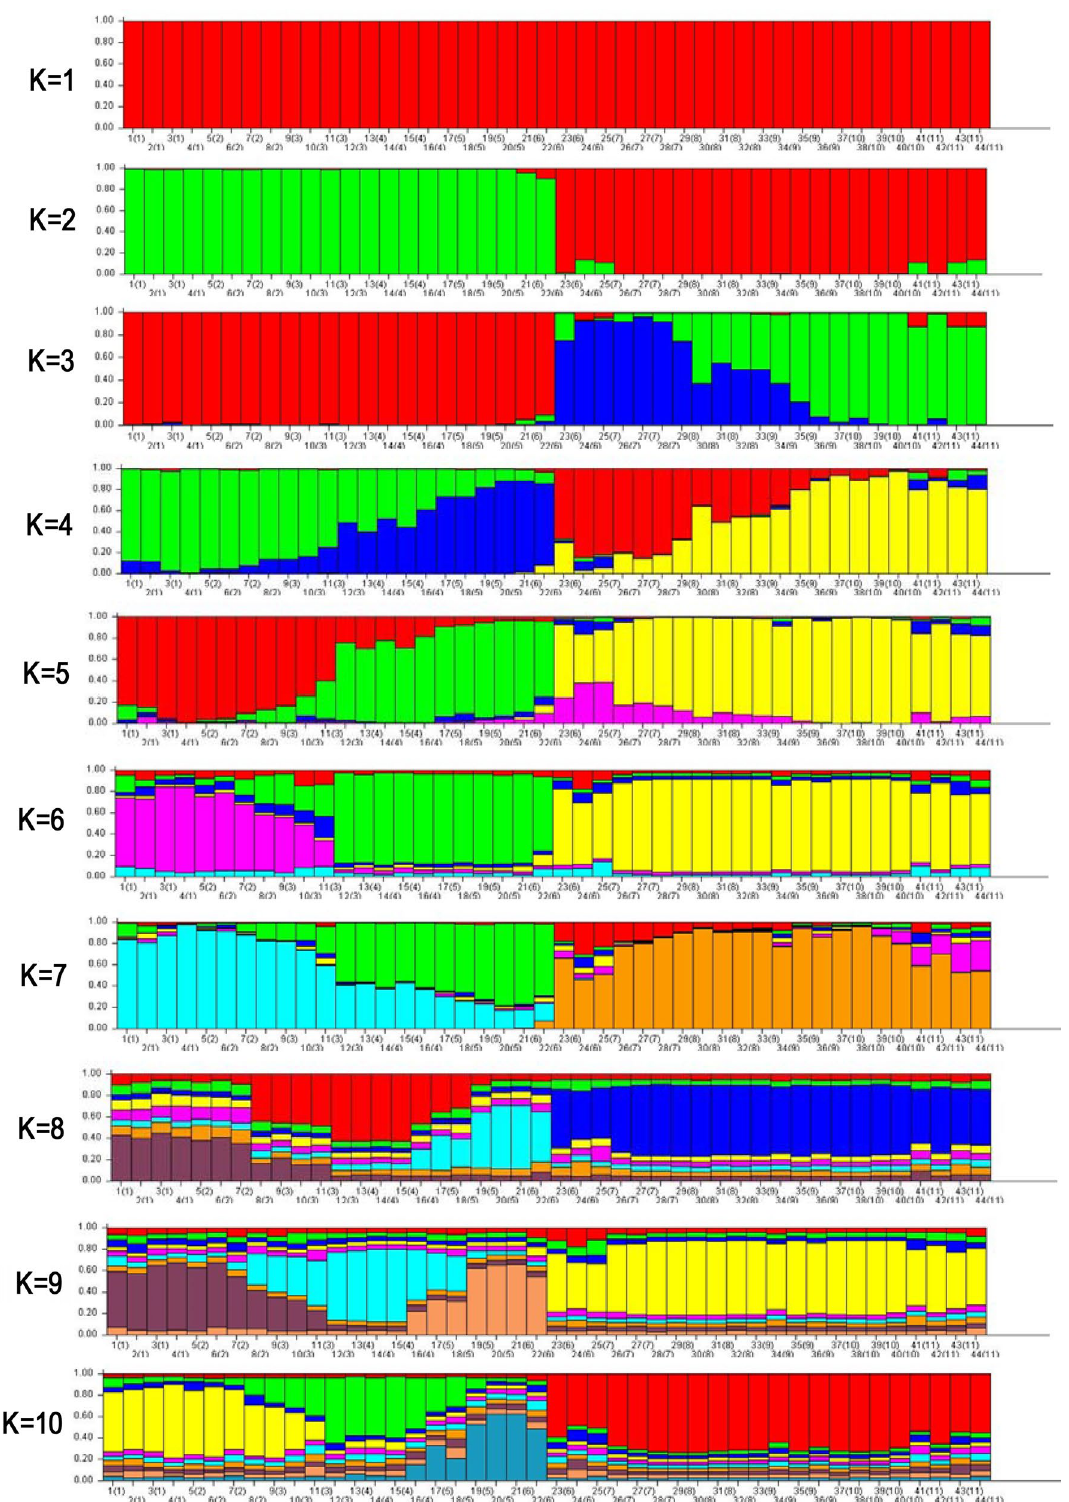
Figure 8. The population membership of the studied Bambara groundnut species group for a priori distinct number of K = 1–10 inferred by the STRU CTU RE software (PRITCHARD LAB, CA, USA). Each accession is signified by a vertical column divided into colored segments that represent the individual’s estimated association fractions in K clusters and black vertical lines isolated the 44 accessions. The numeric number beneath the adjacent bar graph indicates the accession IDs and source of sampled population (11) code in parenthesis that is mentioned as in Table